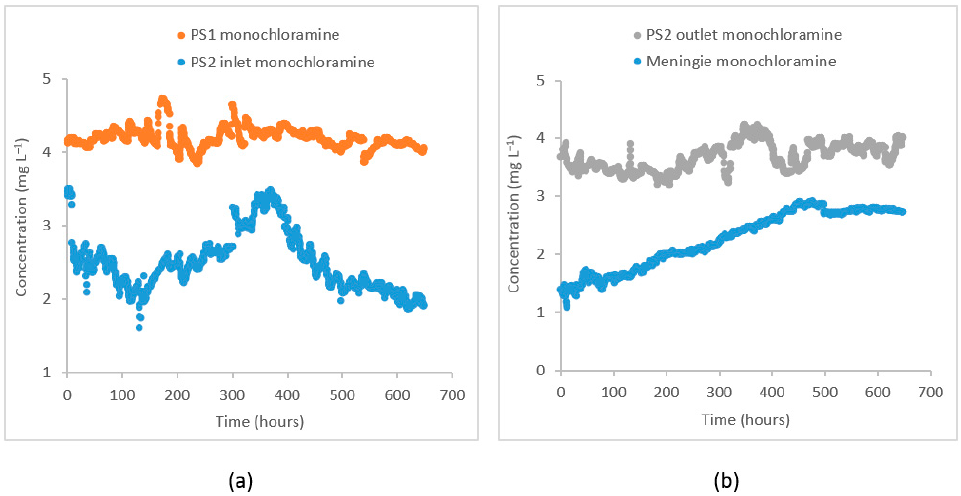
Figure 2. Observed monochloramine time ‒ series at ( a ) PS1 and PS2 inlet and ( b ) PS2 outlet after re ‒ chlorination and at Meningie.